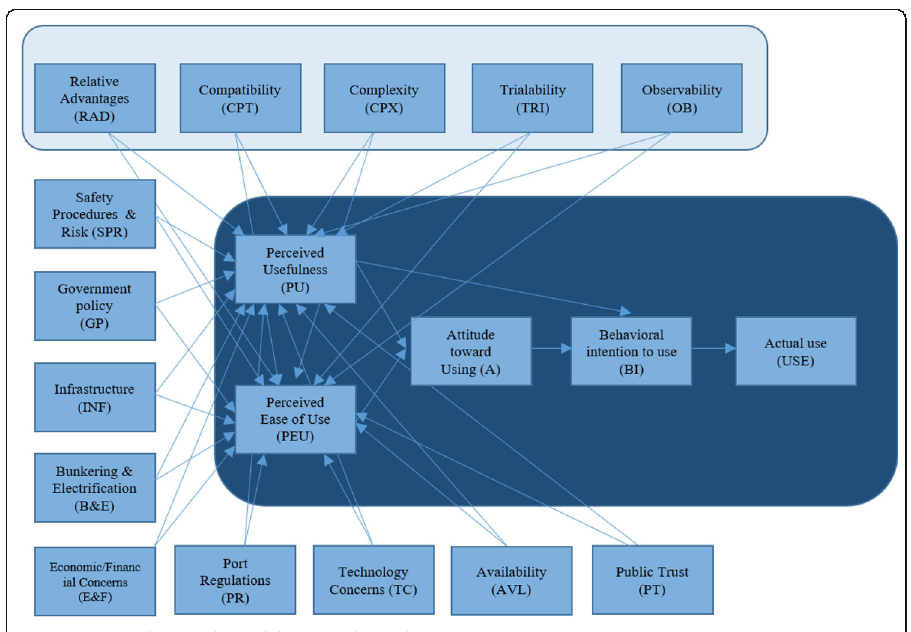
Fig. 1 Proposed research model. Source: by